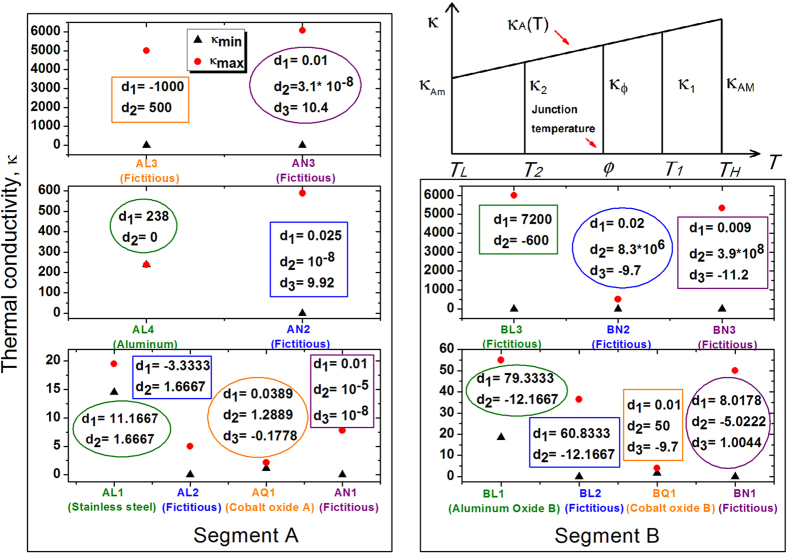
Thermal conductivities of fifteen segment materials.The chemical formula for cobalt oxide A and cobalt oxide B take the form of La0.7Sr0.3CoO3 and LaCoO3. For linear segments, κ(T) = d1 + 2d2T; for quadratic segments, κ(T) = d1 + d2T + d3T2; for nonlinear segments AN1 and BN1, ; for nonlinear segments AN2, AN3, BN2, and BN3, . Note that, in all simulations, the grid node for κ staggers half grid interval toward right. Hence, for example, for AN3, κ(TH) = 6067.6 = κmax, but κf(1) = 6064.6, which exhibits a slightly different value. The subscript “M” of κAM shown in the trapezoid stands for “Maximum” (thus “m”=minimum). The variable κAM is shown in the figure merely for the sake of completeness. It is actually not needed in the derivation of Eq. (20).